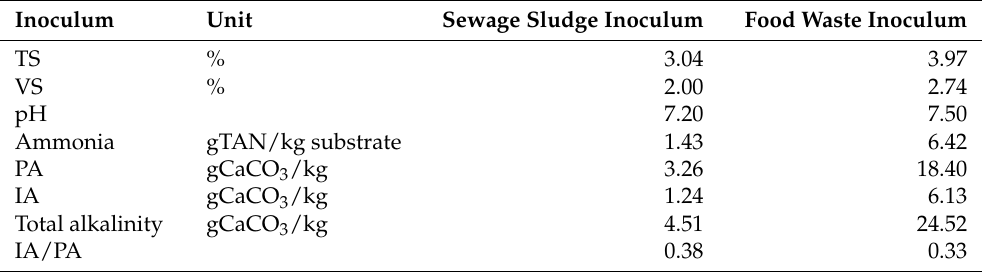
Table A1. Characterisation results of the inoculums used for BMP and in-situ biomethanation